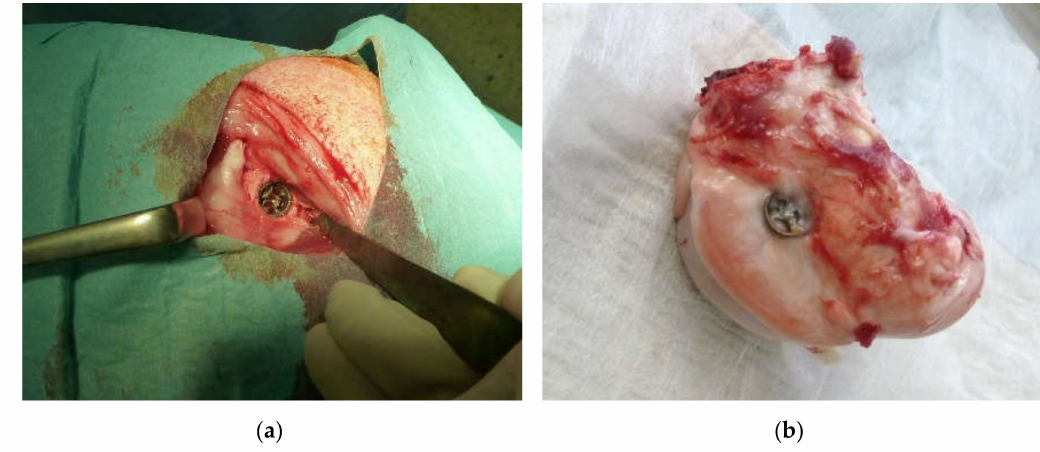
Figure 15. In situ situation during the sheep surgery with the implant inside the drill hole defect ( a